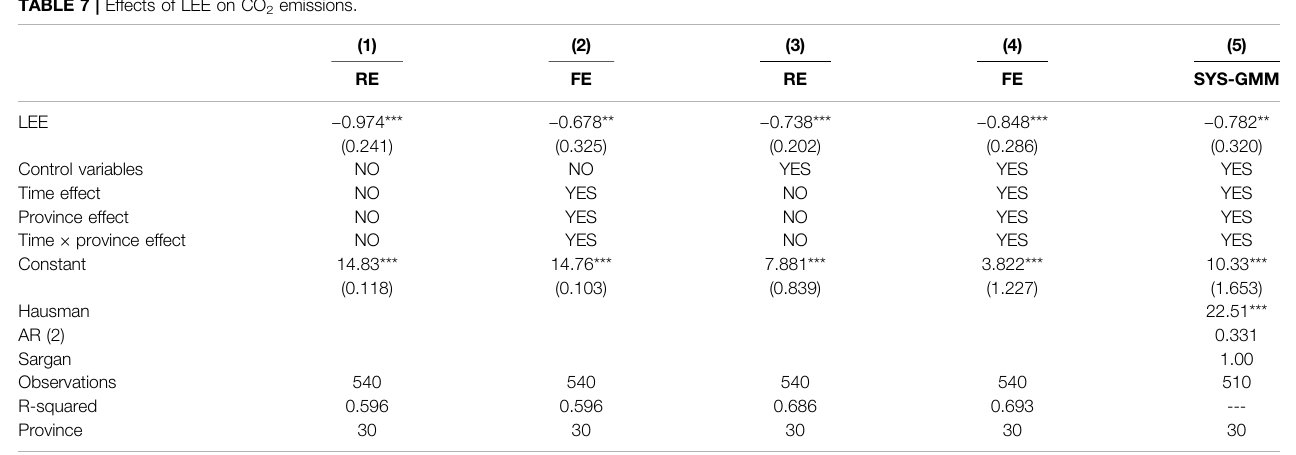
TABLE 7 | Effects of LEE on CO 2 emissions.